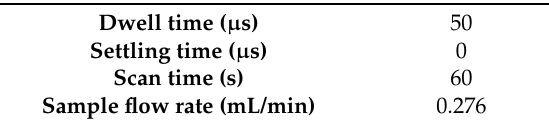
Table 5. Single particle inductively coupled plasma-mass spectrometry (SP-ICP-MS) instrumental